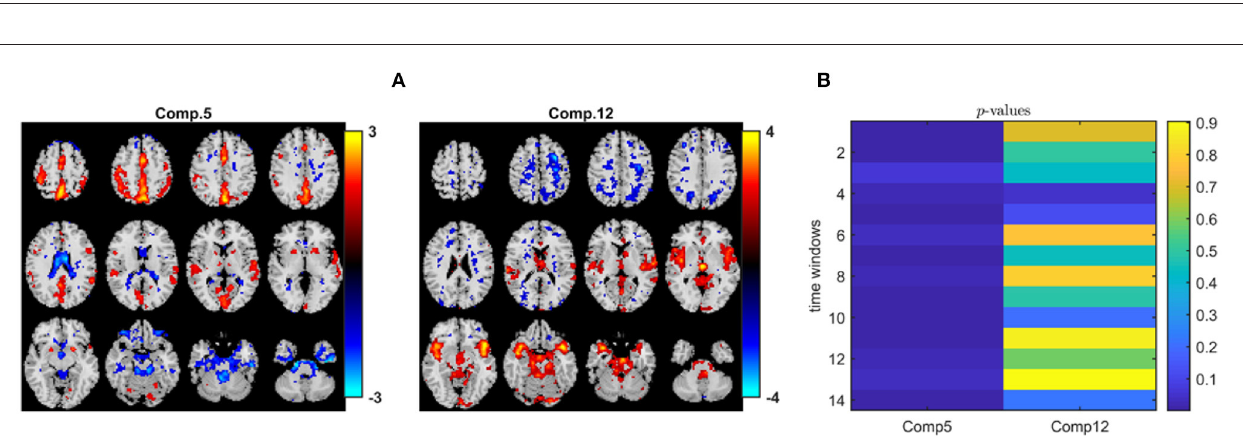
statistically significant in terms of group difference in PARAFAC2 or IVA 4